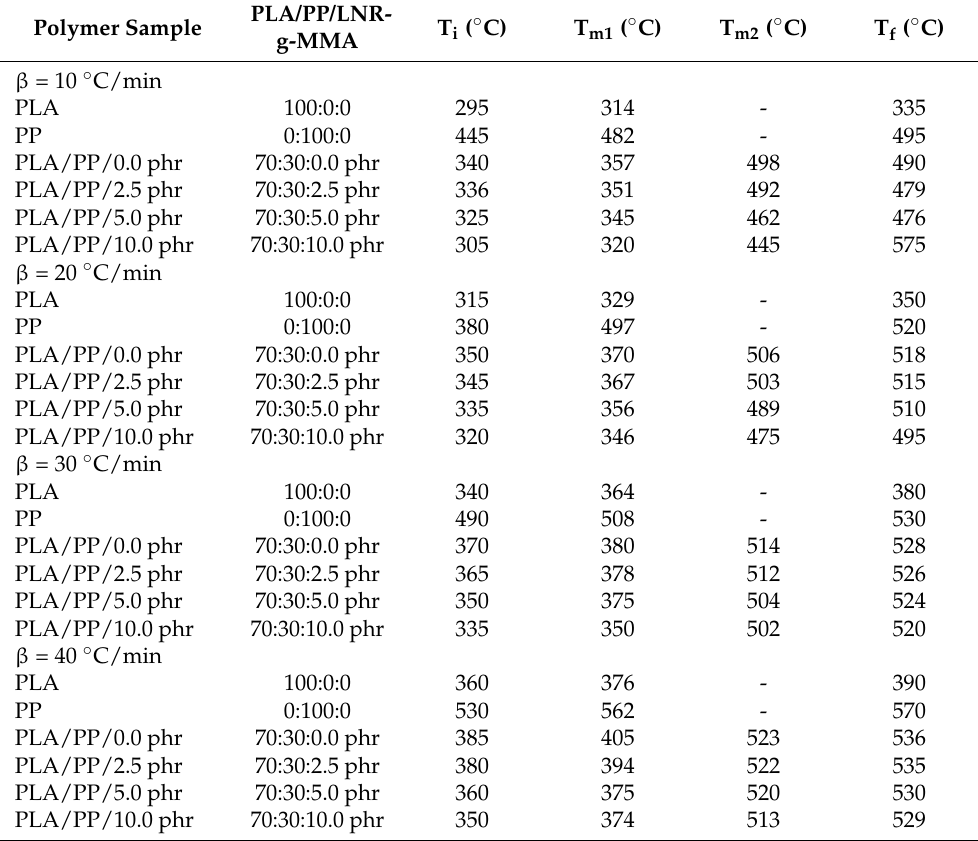
Table 1. Thermal degradation temperatures of PLA, PP, and PLA/PP (70:30 wt%) without and with